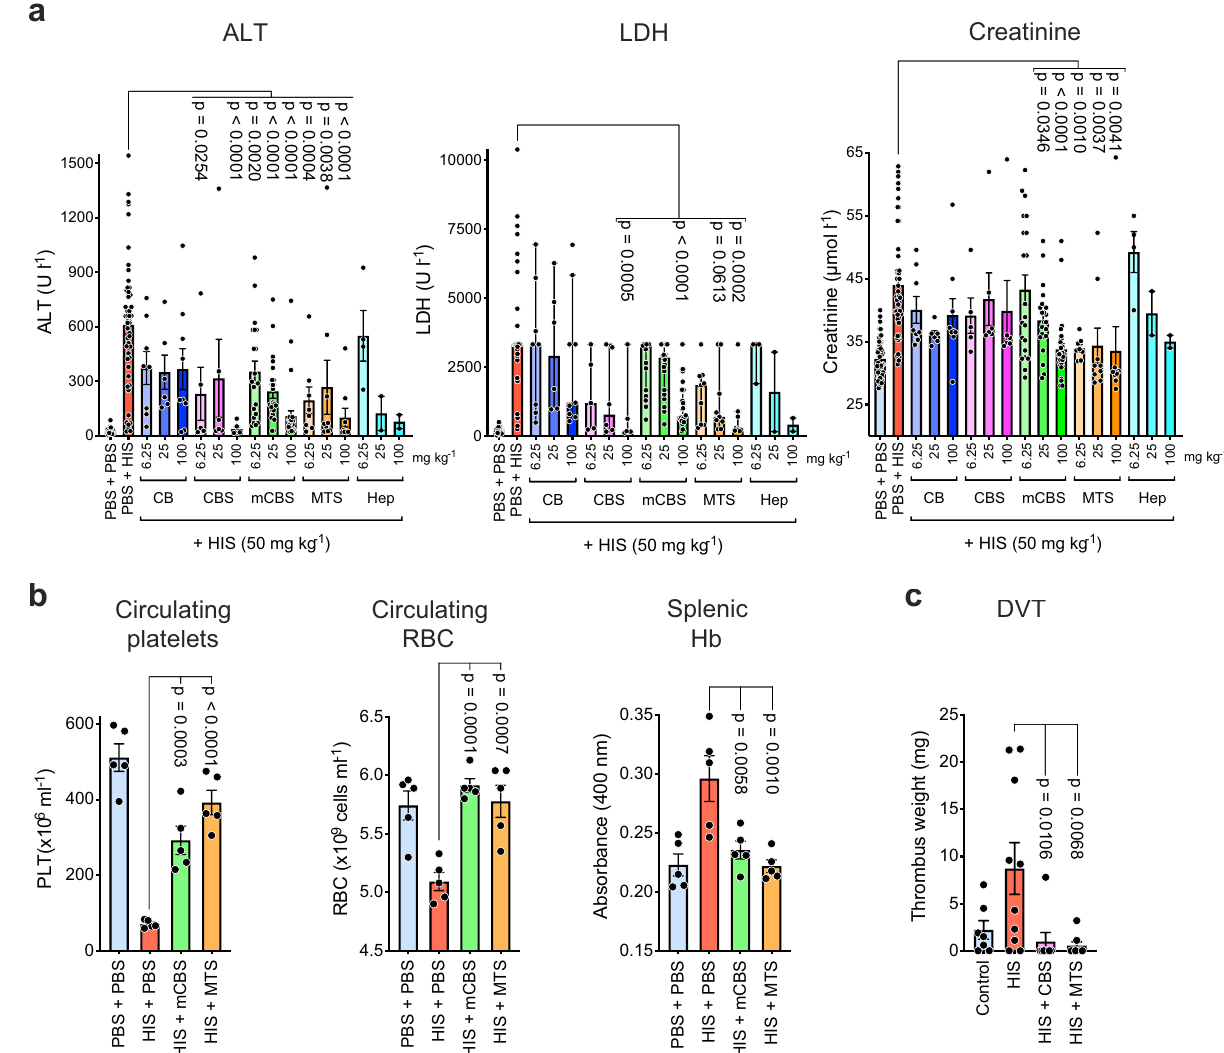
Fig. 4 In vivo SPAs inhibit histone-induced tissue injury, thrombocytopenia, anemia, and DVT. a Mice injected i.p. with SPA and heparin (Hep) doses (as indicated) 10 min prior to i.v. injection of histones (50 mg kg − 1 ), had blood collected 4 h post histones for assessment of liver (alanine aminotransferase, ALT), kidney (creatinine), and general tissue (lactate dehydrogenase, LDH) damage. Data pooled from 15 separate experiments, with n = 2 – 50 mice per treatment. b Mice ( n = 5/group), treated as above but receiving one SPA dosage (100 mg kg − 1 ), had their blood and spleens collected 10 min post histones for assessment of circulating platelets and RBC and splenic hemoglobin (Hb). c Impact of CBS and MTS on a mouse model of histone-induced DVT ( n = 7 – 10 mice per group). All data, except LDH values, are presented as mean ± s.e.m. and analyzed by one-way ANOVA with Dunnett ’ s correction for